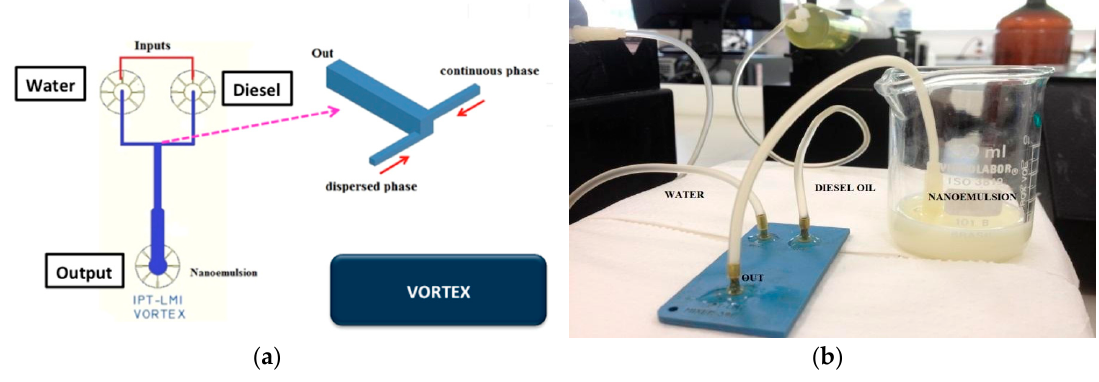
Figure 7. Vortex microfluidic device: ( a ) device geometry; ( b ) fabricated device in LTCC.